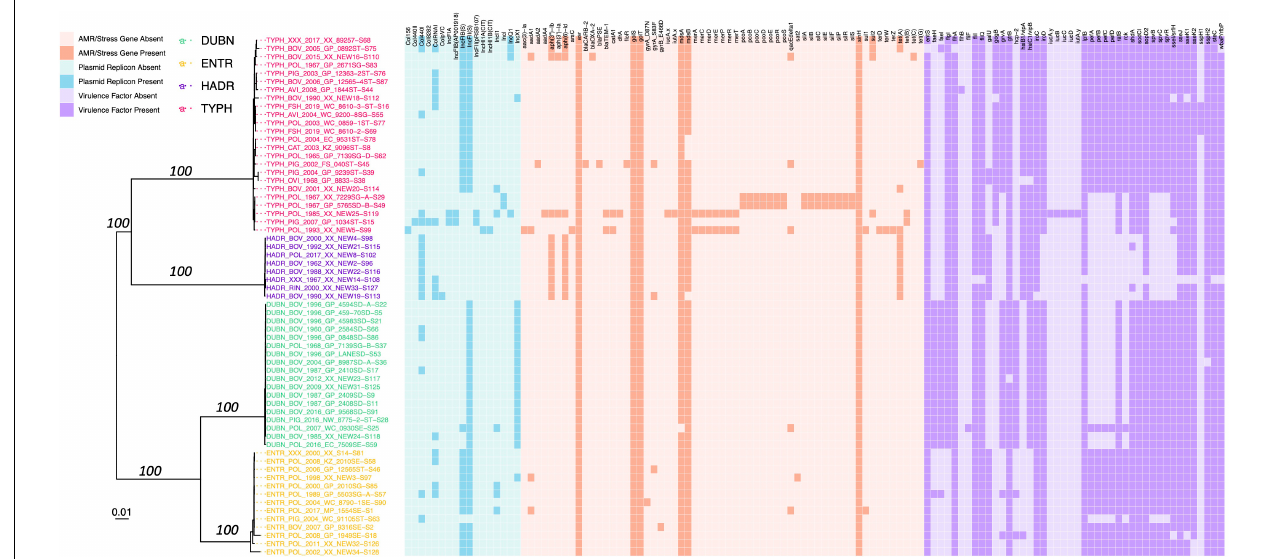
FIGURE 2 | Maximum likelihood phylogeny constructed using core SNPs identified among the genomes of 63 Salmonella strains isolated in conjunction with this study. Tip label colors denote isolate serotypes, and branch labels denote ultrafast bootstrap support percentages out of 1,000 replicates (selected for readability). The heatmap to the right of the phylogeny denotes the presence and absence of (i) plasmid replicons (blue), (ii) antimicrobial resistance (AMR) and stress response determinants (orange), and (iii) variably detected virulence factors (purple) in each genome. The phylogeny is rooted at the midpoint with branch lengths reported in substitutions per site. Core SNPs were identified among all genomes using kSNP3. Plasmid replicons were identified using ABRicate and the PlasmidFinder database, using minimum identity and coverage thresholds of 80 and 60%, respectively. AMR and stress response determinants were identified using AMRFinderPlus. Virulence factors were identified using ABRicate and VFDB, using minimum identity and coverage thresholds of 70 and 50%, respectively. Virulence factors detected in all genomes were excluded for readability ( Supplementary Table 2 ). The phylogeny was constructed and annotated using IQ-TREE and bactaxR/ggtree, respectively. DUBN, S. Dublin; ENTR, S. Enteritidis; HADR, S. Hadar; TYPH, S.